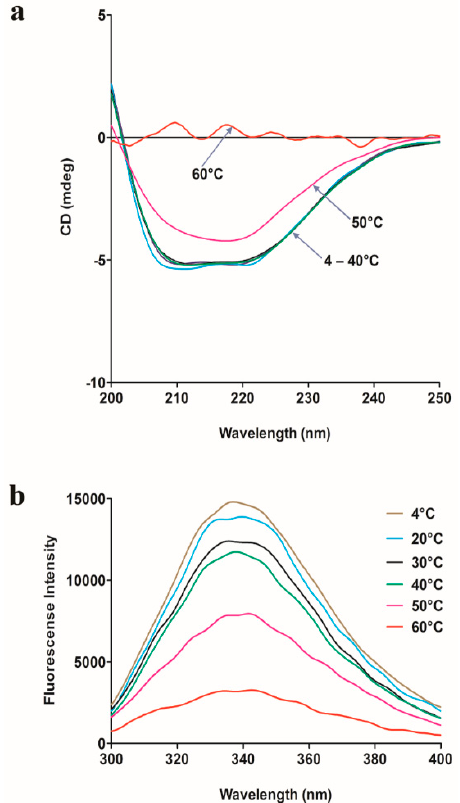
Figure 5. Spectroscopic analysis of SpG6PD1. ( a ) Circular dichroism (CD) spectra of SpG6PD1: The CD spectra were measured at 25 °C after incubating a 0.3 mg/mL protein sample at 4, 20, 30, 40, 50, and 60 °C for 1 h. ( b ) Fluorescence spectra of SpG6PD1: the fluorescence spectra were measured at 25 °C after incubating 1 µM of the enzyme at 4, 20, 30, 40, 50, and 60 °C for 1 h upon excitation at 280 nm.